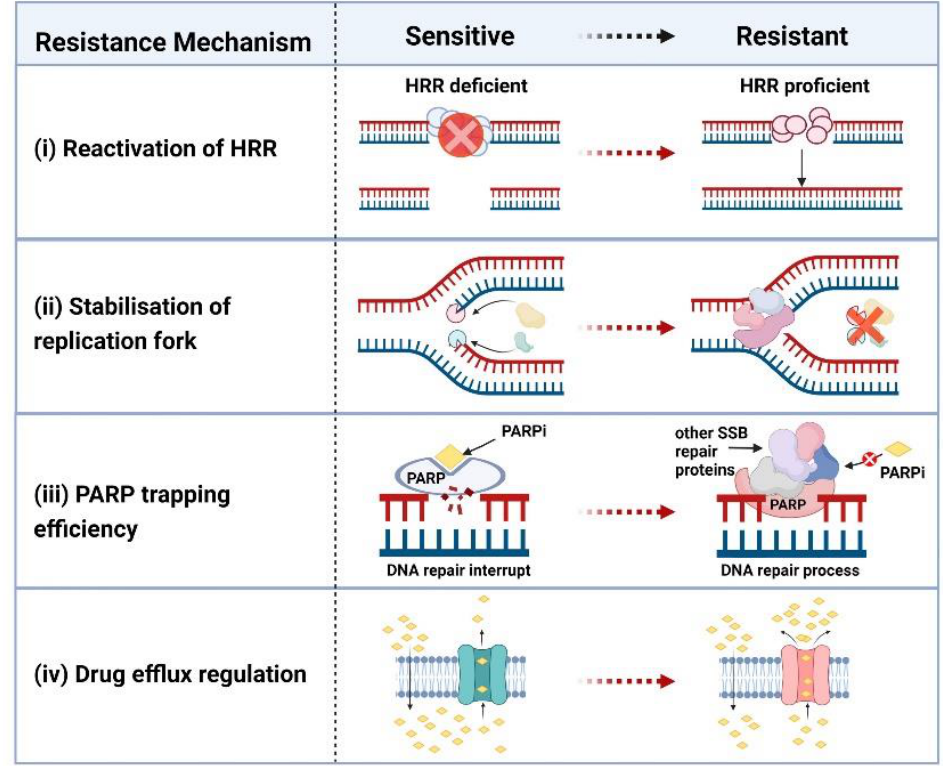
Figure 4. Mechanisms of PARP inhibitor resistance. There are four generally accepted mechanisms of PARPi resistance. ( i ) Homologous Recombination (HRR) restoration. The synthetic lethality is based on HRR deficiency and PARP inhibition. When HR reactivates in cancer cells for reasons including the occurrence of a reversion mutation, DNA damage can be repaired by the HRR pathway, cancer cells survive and become resistant to PARP inhibitors (PARPis). ( ii ) Stabilisation of the replication fork. Some HRR-associated proteins also function to stabilise stalled DNA replication forks. In HRR deficient cells (sensitive to PARPi), stalled replication forks will be degraded by DNA nucleases (e.g., MRE11, MUS81). PARPi resistant cells protect the replication fork by inhibiting the recruitment of DNA nucleases, therefore maintaining genomic stability. ( iii ) A PARP mutation can affect the ability of PARPi to bind PARP, leading to a decrease in PARP trapping. Mutated PARP can recruit other DNA repair proteins to correct single-strand breaks, leading to PARPi resistance and cell survival. ( iv ) Increase in drug efflux. Some PARPis (e.g., olaparib) are substrates of the transmembrane glycoprotein MDR1 (multi-drug resistance protein 1), also known as p-glycoprotein 1. By upregulating the activities of MDR1, PARPi is transported out of the cancer cells. Created with